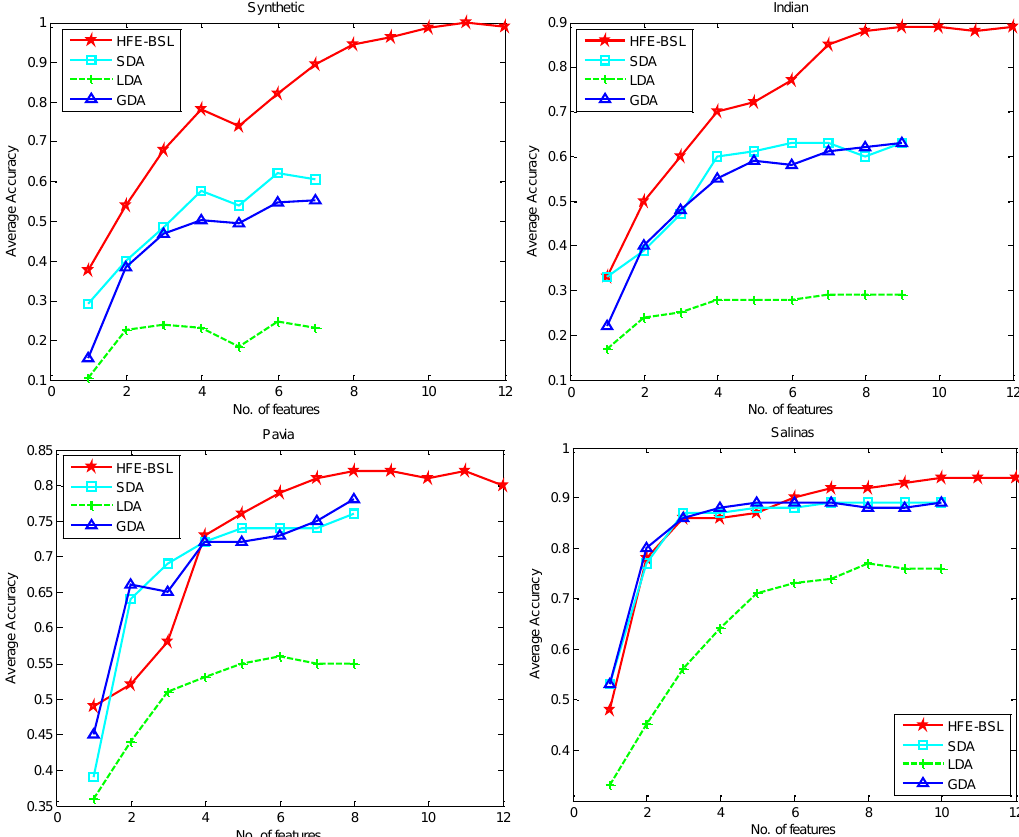
Figure 2. Classification accuracy versus number of extracted features using SVM classifier and 16 training